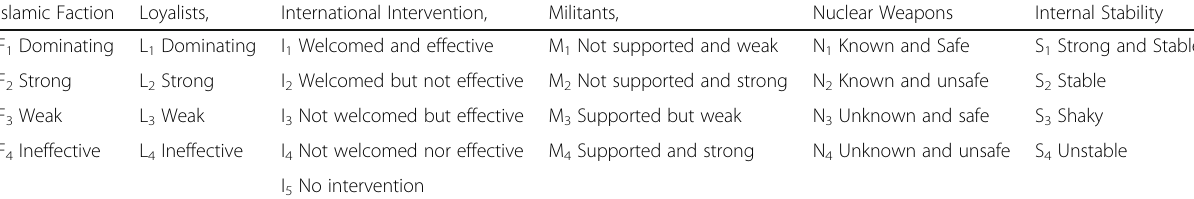
Table 1 Variables developed through FAR and used in developing the scenarios Islamic Faction Loyalists, International Intervention, Militants,